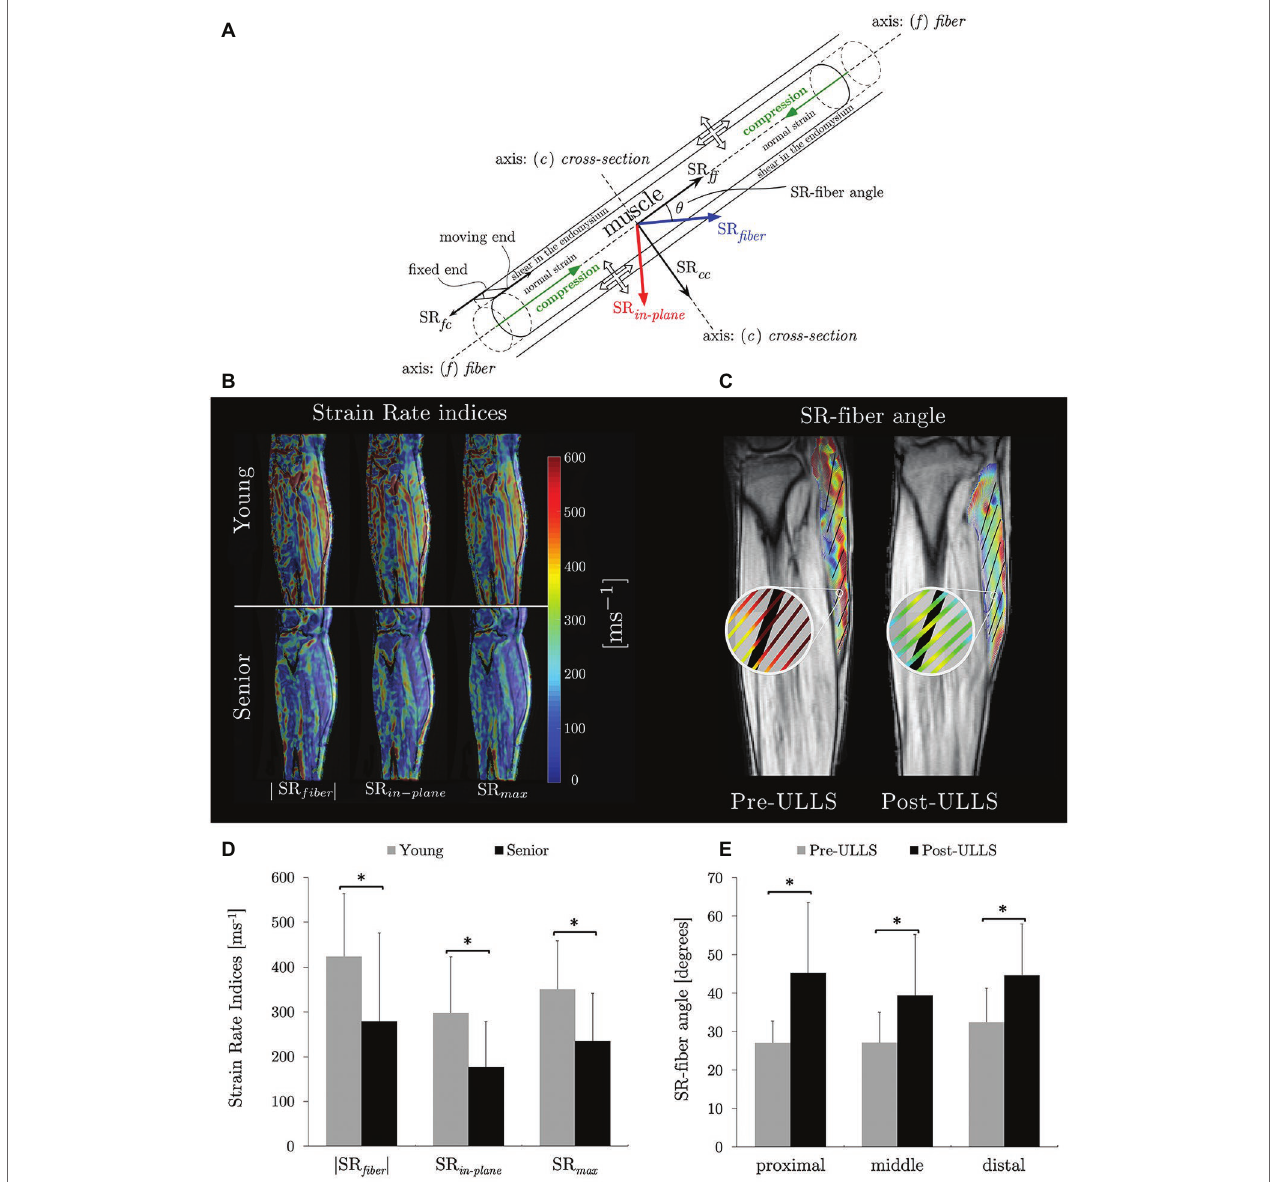
FIGURE 2 | Schematic of a muscle fiber and endomysium with the principal basis and fiber basis defined with respect to the muscle fiber. The muscle fiber is shown contracting (green arrows) while the endomysium experiences a shear strain (end attached to the muscle contracts with the muscle fiber while the other end stays fixed resulting in a shear strain). The direction of the strain rate components in the two basis sets (SR fiber and SR in-plane in the principal basis and SR ff and SR cc in the muscle fiber basis) as well as the angle q between these two basis sets, SR-fiber angle are shown. The thick (unfilled) arrows show the lateral transmission of force pathways: from the cross-bridges of the myofilaments through the protein network on the sarcolemma to the extracellular matrix. Arrows indicate normal and shear strains (A) reproduced with permission from Wiley publisher of Sinha et al. (2018). Strain rate maps of the normal strain rates (SR fiber and SR in-plane ) and shear strain rates (SR max ) in a young and aging subject at the same force level. The color maps are color-coded according to the legend provided with the figure. Color maps are overlaid on the magnitude image at the corresponding frame; maps show lower values in both the normal strain rates in the aging cohort (B) reproduced with permission from Wiley publisher of Sinha et al. (2018). Streamlines of eigenvectors corresponding to SR fiber overlaid on fiber directions (in black, tracked from fascicle orientations) for one slice of the same subject pre- and post-suspension at the peak of the contraction phase. This shows the difference in angle enclosed by SR fiber and muscle fiber (SR-fiber angle) (C) reproduced with permission from Wiley publisher of Malis et al. (2018a). Box plots of SR indices evaluated in the MG that showed significant difference between young and aging subjects (D) . Box plots of SR-fiber angle showing significant differences in all three regions of the MG on unloading (E) . Significant differences in (D) and in (E) are denoted by ‘ *